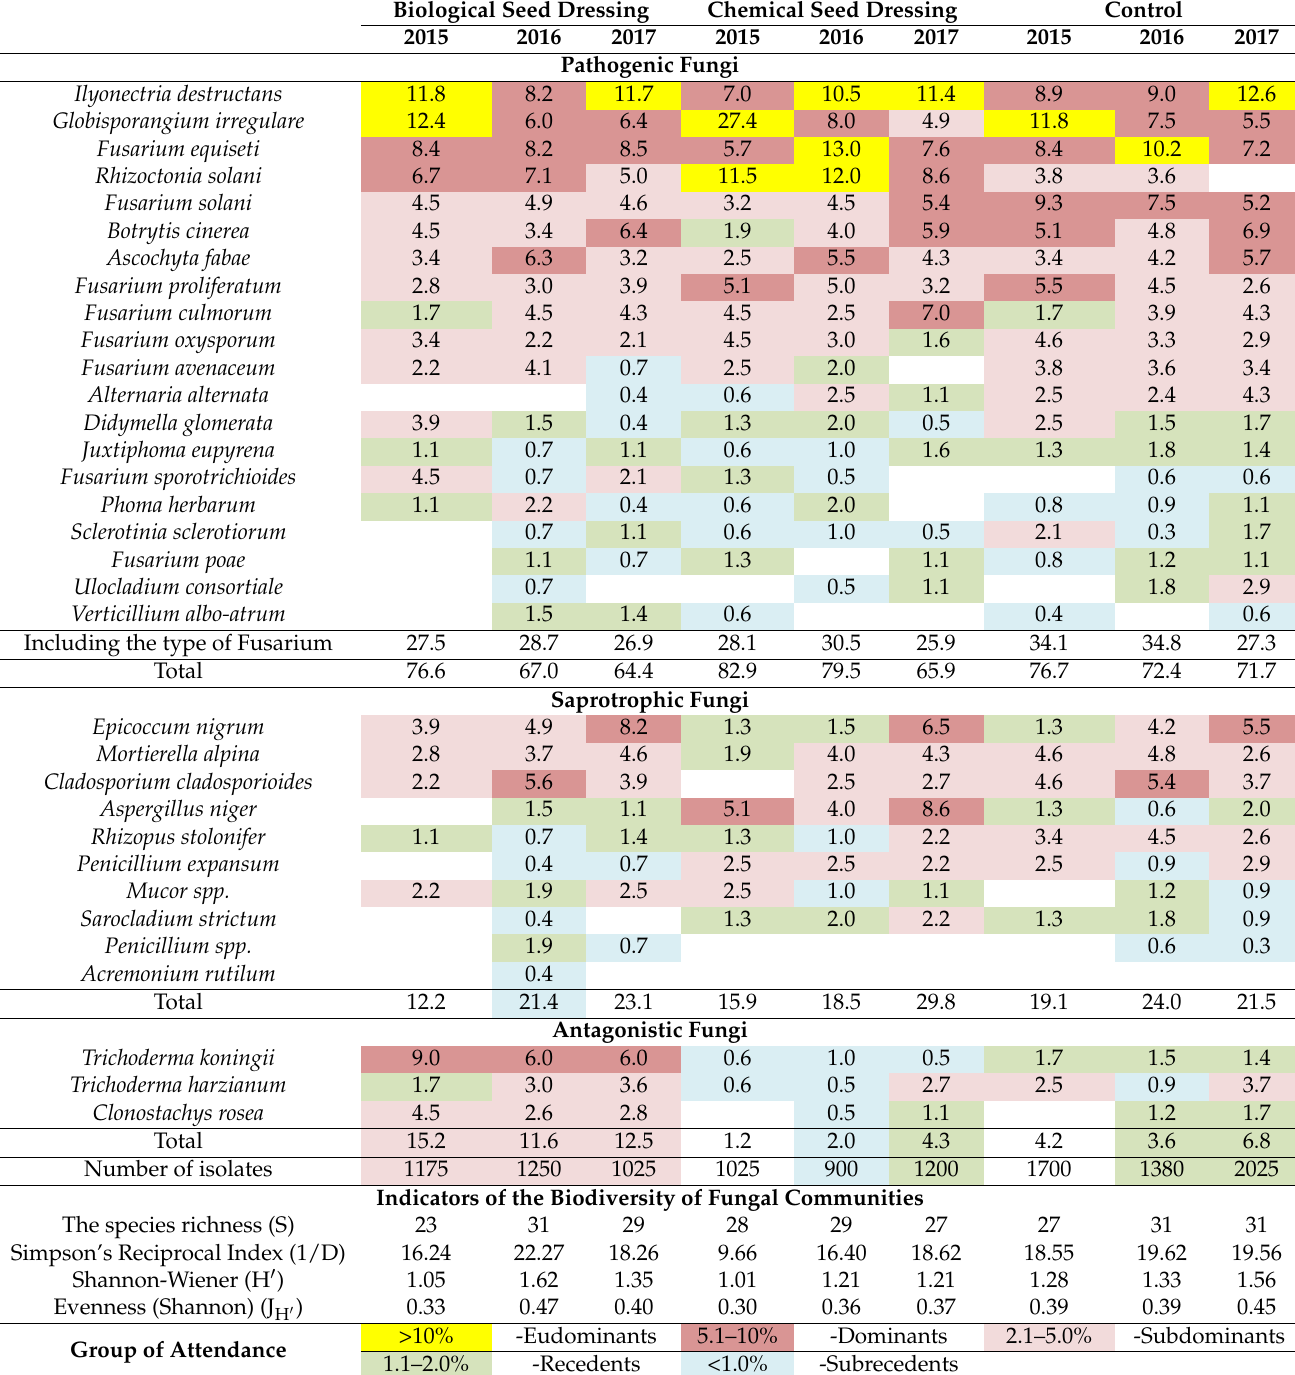
Table 3. Impact of seed treatment and growing season on frequency, biodiversity, and the trophic structure of microorganisms colonizing infected broad bean